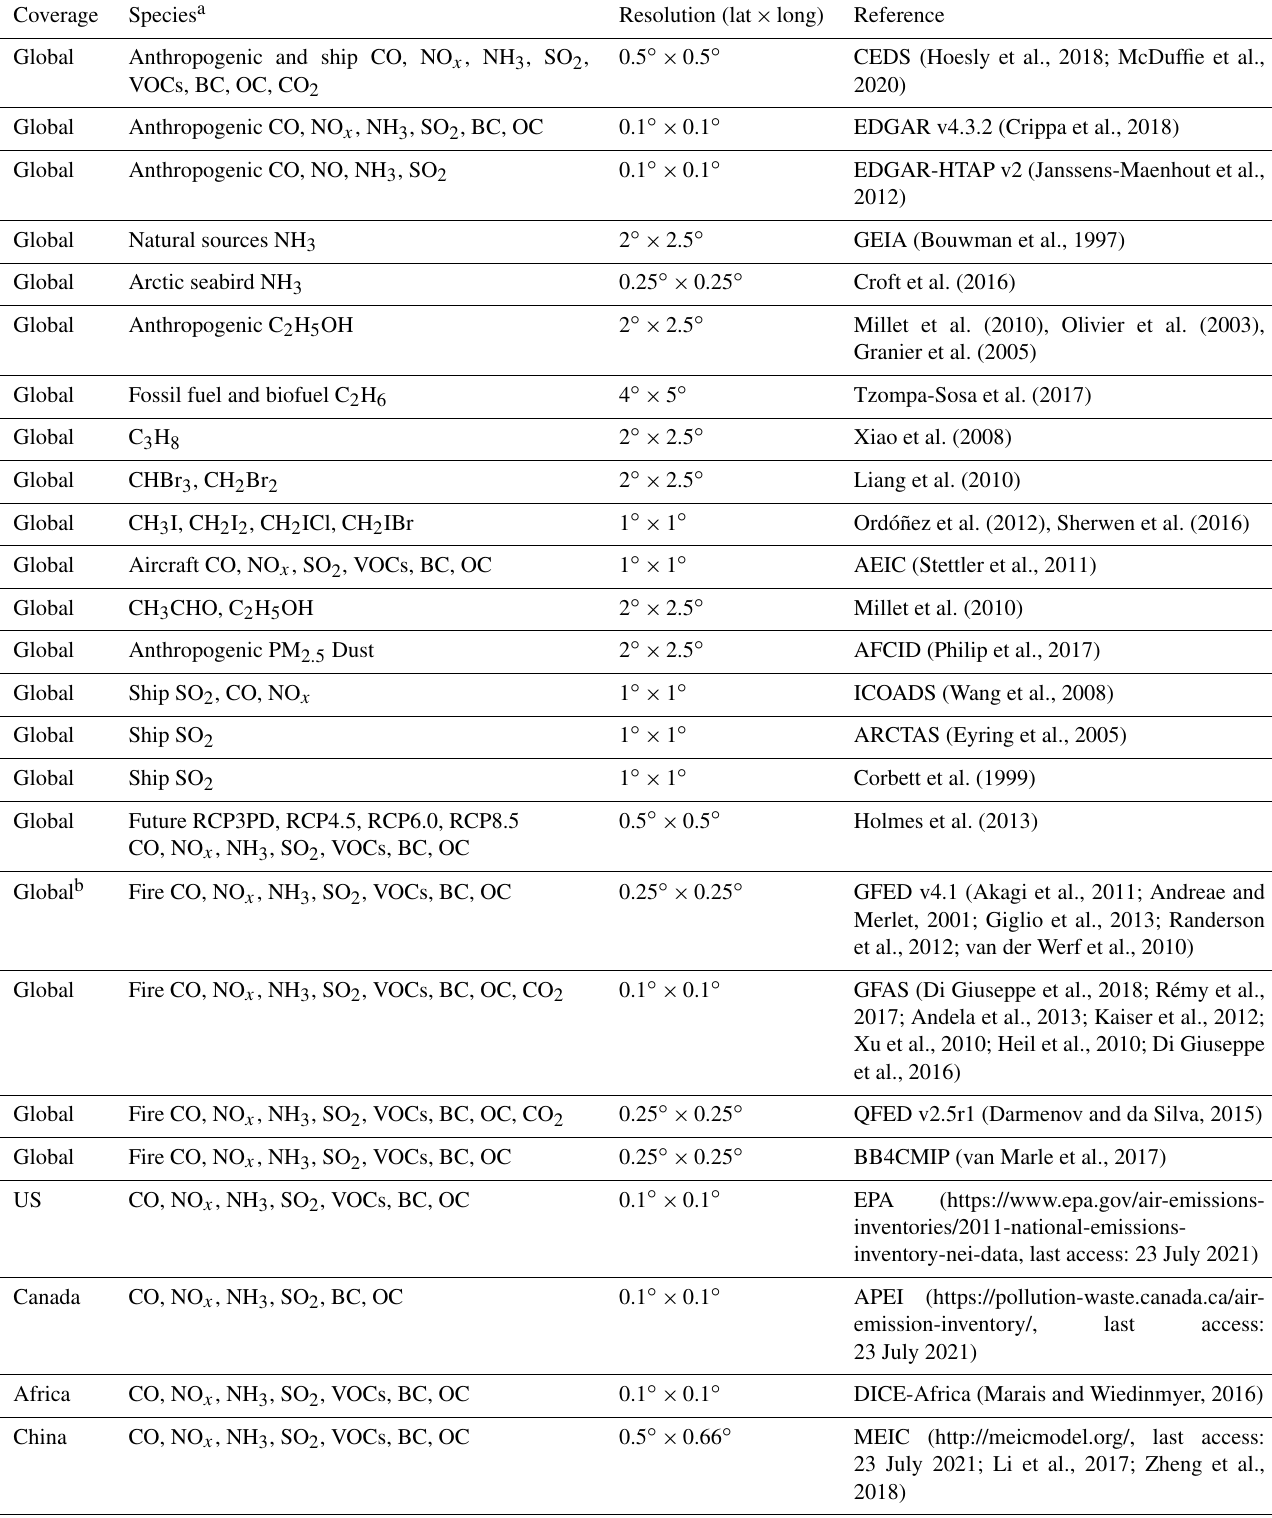
Table 1. Emission inventories currently in the default HEMCO 3.0